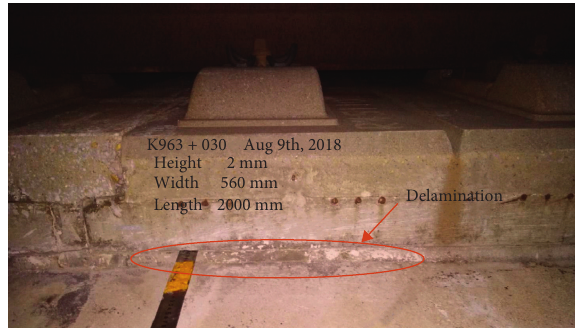
Figure 2: Example of delamination of CRTS II SBTS from the on- site survey of the Beijing-Shanghai